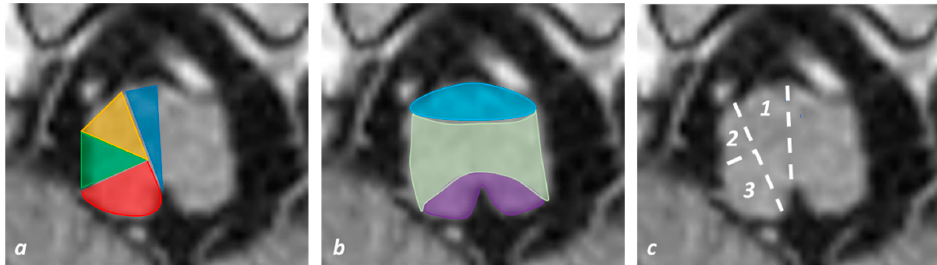
Figure 2. Vascular territories, anatomical division and main supplying arteries of the medulla oblongata superimposed on an axial T1W MRI slice . ( a ) Vascular territories at the level of the medulla oblongata as in Figure 1a: anteromedial group arteries (blue), anterolateral group arteries (yellow), lateral group arteries (green) and posterior group (red). ( b ) Anatomical segments as in Table 3: anterior segment (light blue), tegmentum (light green) and posterior segment (violet). ( c ) Main supplying arteries: VA (paramedian branches) and ASA (1); VA (2); VA and PICA (3).